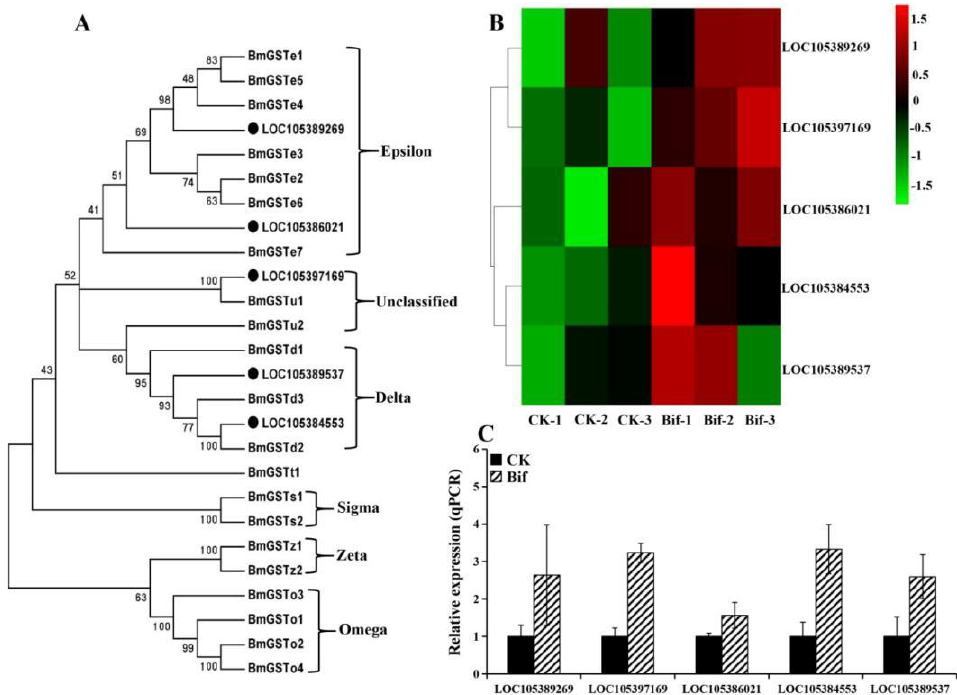
Figure 5. ( A ) Phylogenetic relationships of GSTs from Plutella xylostella (black circle) and Bombyx mori . ( B ) Expression profiles (FPKM value) of five GSTs in P. xylostella . X -axis: sample name, Y -axis: GSTs. The colors indicated the expression levels of GSTs, and red indicated high expression and green indicated low expression. ( C ) Expression profiles of five GSTs in P. xylostella by qRT-PCR.